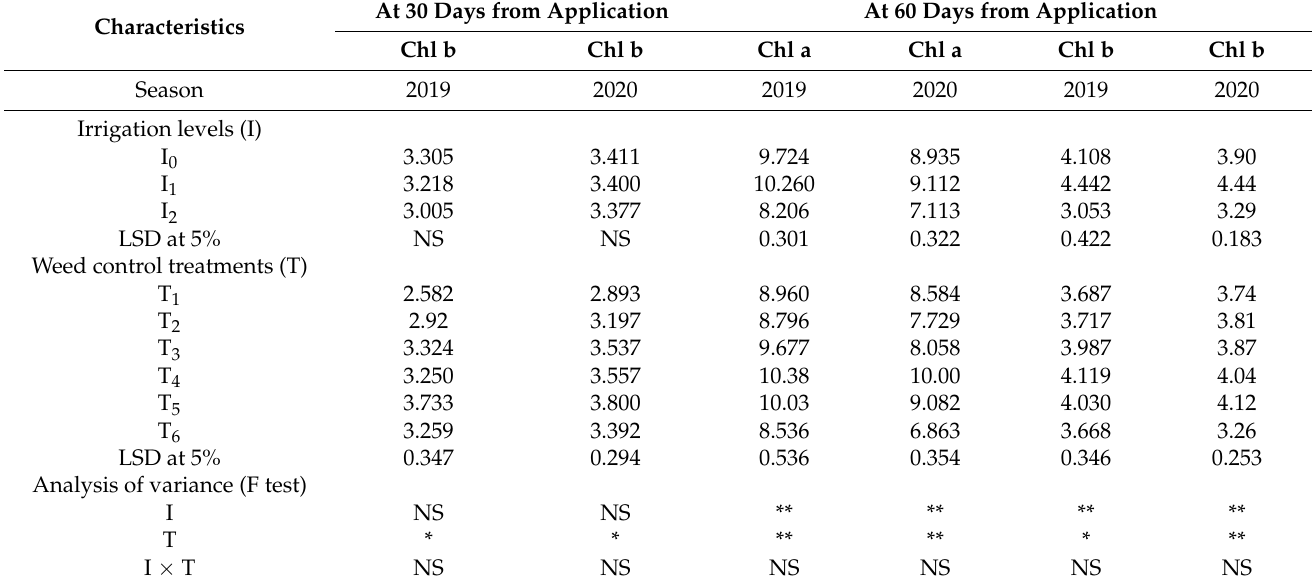
Table 9. Effect of irrigation levels and weed control treatments on (Chl b µ g mL − 1 ) at 30 days from herbicides application and (Chl a and Chl b µ g mL − 1 ) at 60 days from herbicides applications in the 2019 and 2020